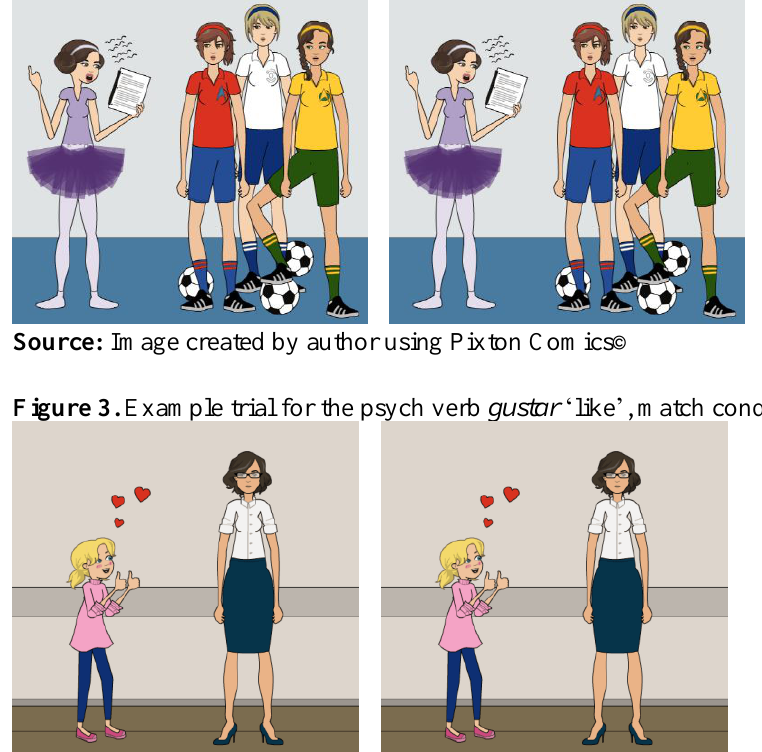
Source: Image created by author using Pixton Comics© Figure 2. Example trial for the actional verb leer ‘read’, mismatch condition